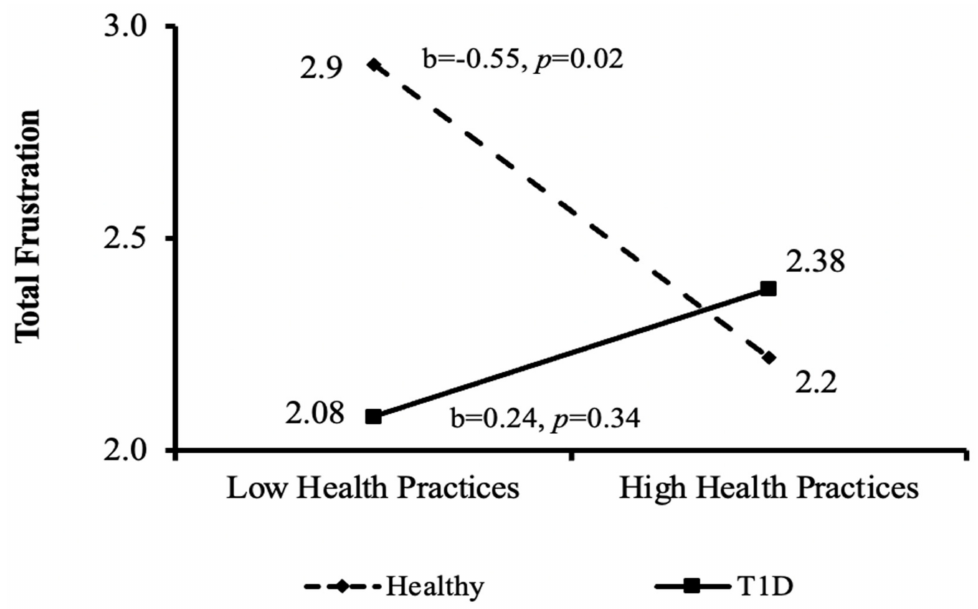
Figure 4. Interactions between the independent variable (good health practices) and the mediating variable (total frustration) by the moderating variable (health condition group). T1D = type-1 diabetes.